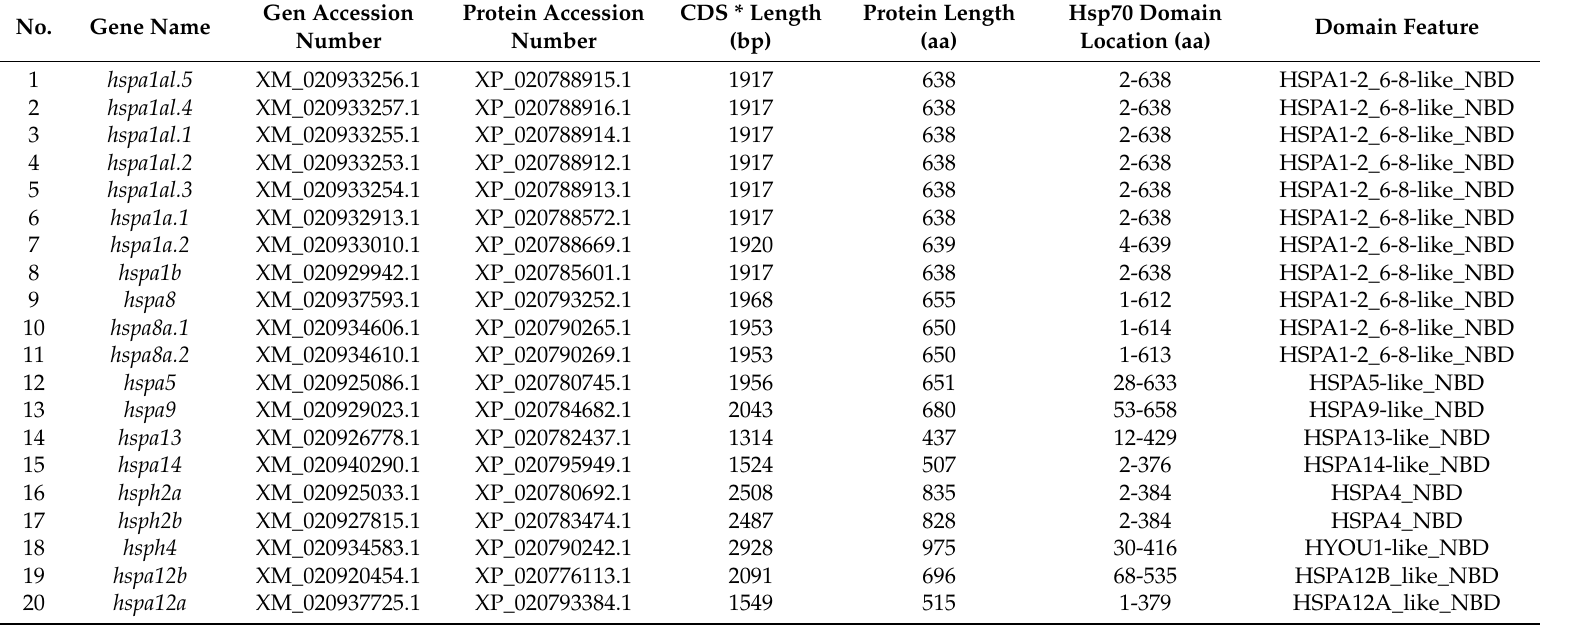
Table 1. Summary of 17 Hsp70 genes identified in genome of B.